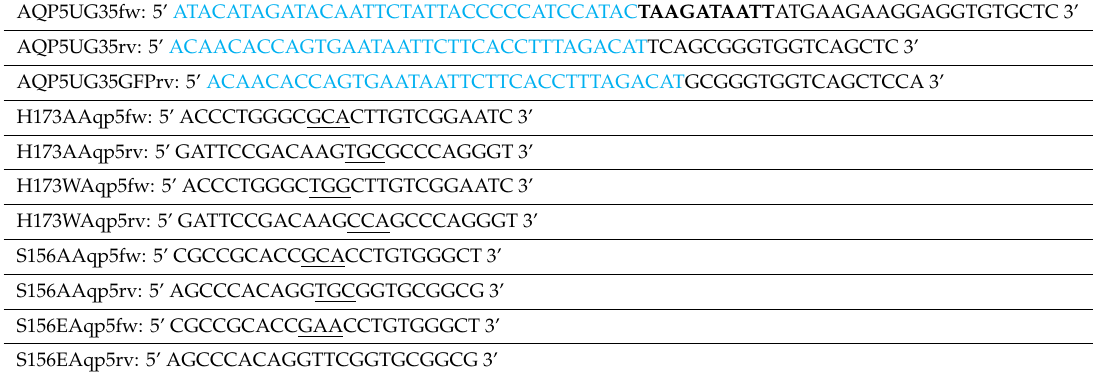
Table 1. Nucleotide sequences of the PCR primers used for generating the mutants analyzed in the present study. Nucleotide sequences in turkish are for homologous recombination with pUG35; the bold sequence is a yeast Kozak sequence, while AQP5 sequences are shown in black. The codon changed in each primer is underlined. Non-tagged AQP5 mutations were made by transforming YSH1770 with Bam HI, Sal I, and Hin dIII digested pUG35 and two PCR products: one generated by GFP tagged versions were made in the same way except for using the AQP5UG35GFPrv primer instead of AQP5UG35rv. Non-tagged and GFP tagged wild type AQP5 were generated by transforming YSH1770 with Bam HI, Sal I, and Hin dIII digested pUG35 and PCR products generated by